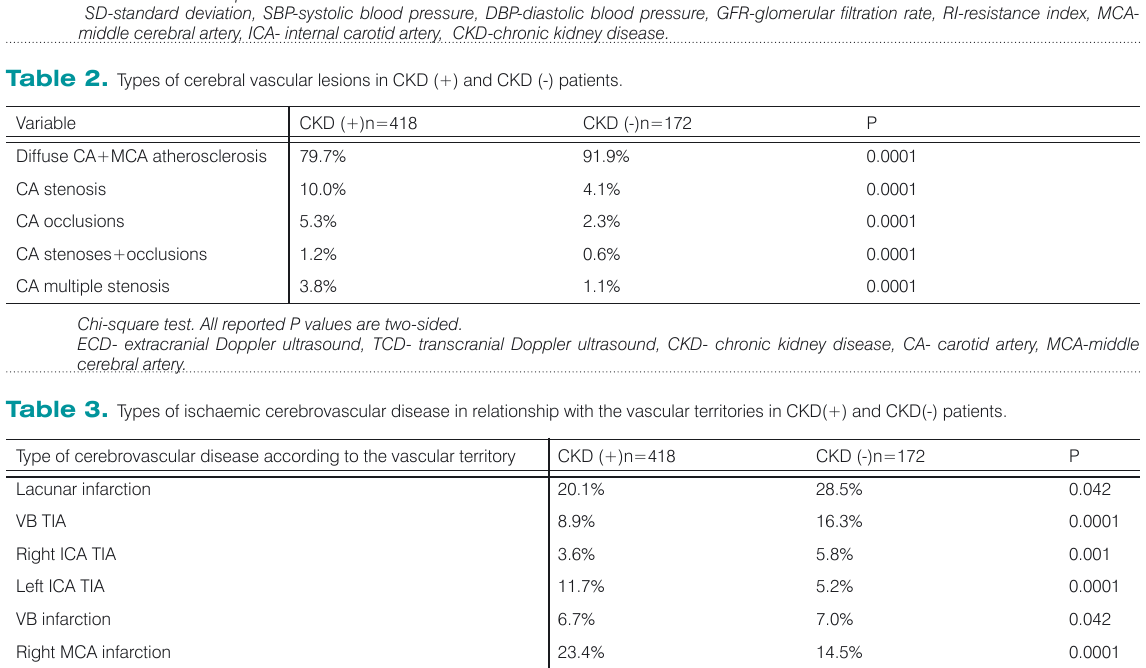
Chi-square test. All reported P values are two-sided. Significance was considered as P<0.05. VB- vertebro-basilar, TIA- transient ischaemic attack, ICA-internal carotid artery, MCA-middle cerebral artery, CKD- chronic kidney disease.